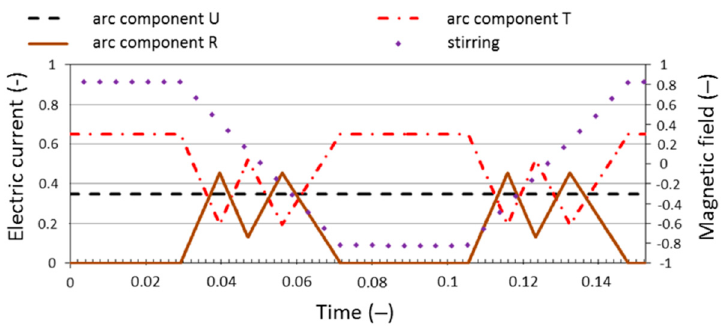
Figure 7. Time evolution during a stirring period of the currents carried by the arc components U, T